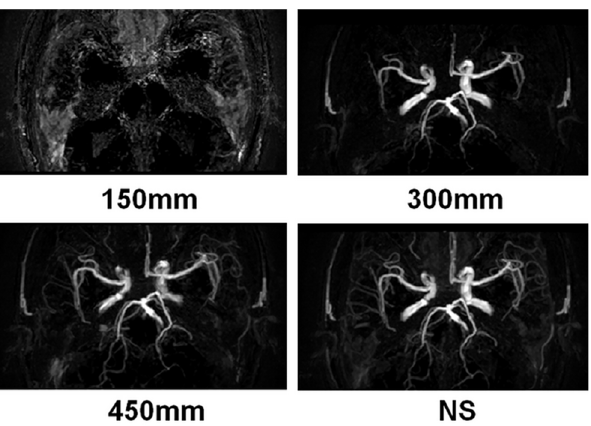
Fig 2. Optimization of inversion slab thickness for SNAP imaging. It is clear that the SNAP MRA performance is best when the inversion pulse was non-selective (NS) compared to the inversion slab thicknesses considered. This implementation was used for the subsequent validation scans.